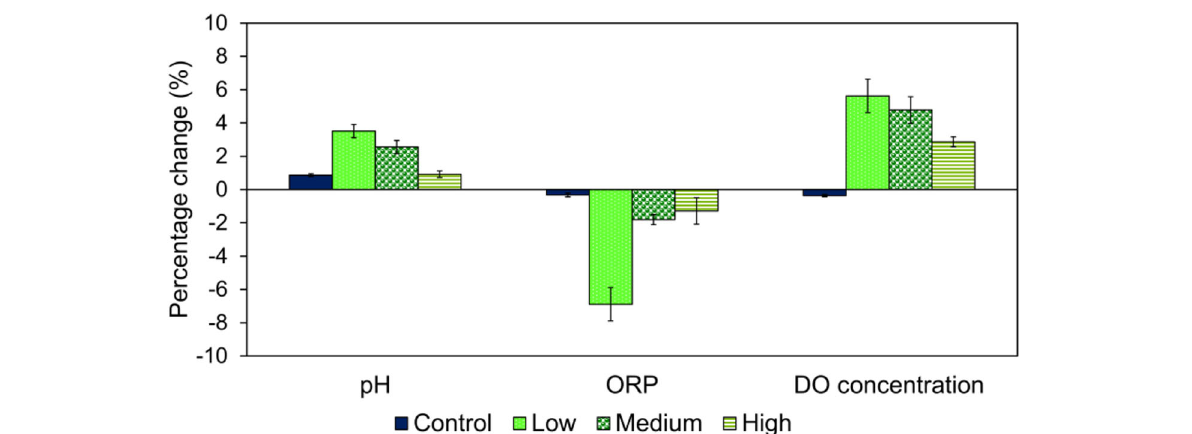
Fig. 4 Results of pH, ORP and DO concentration of water after magnetization at low (0.1 – 0.5 mL s − 1 ), medium (1.0 – 1.5 mL s − 1 ) and high (2.0 – 2.5 mL s − 1 ) flow rate,